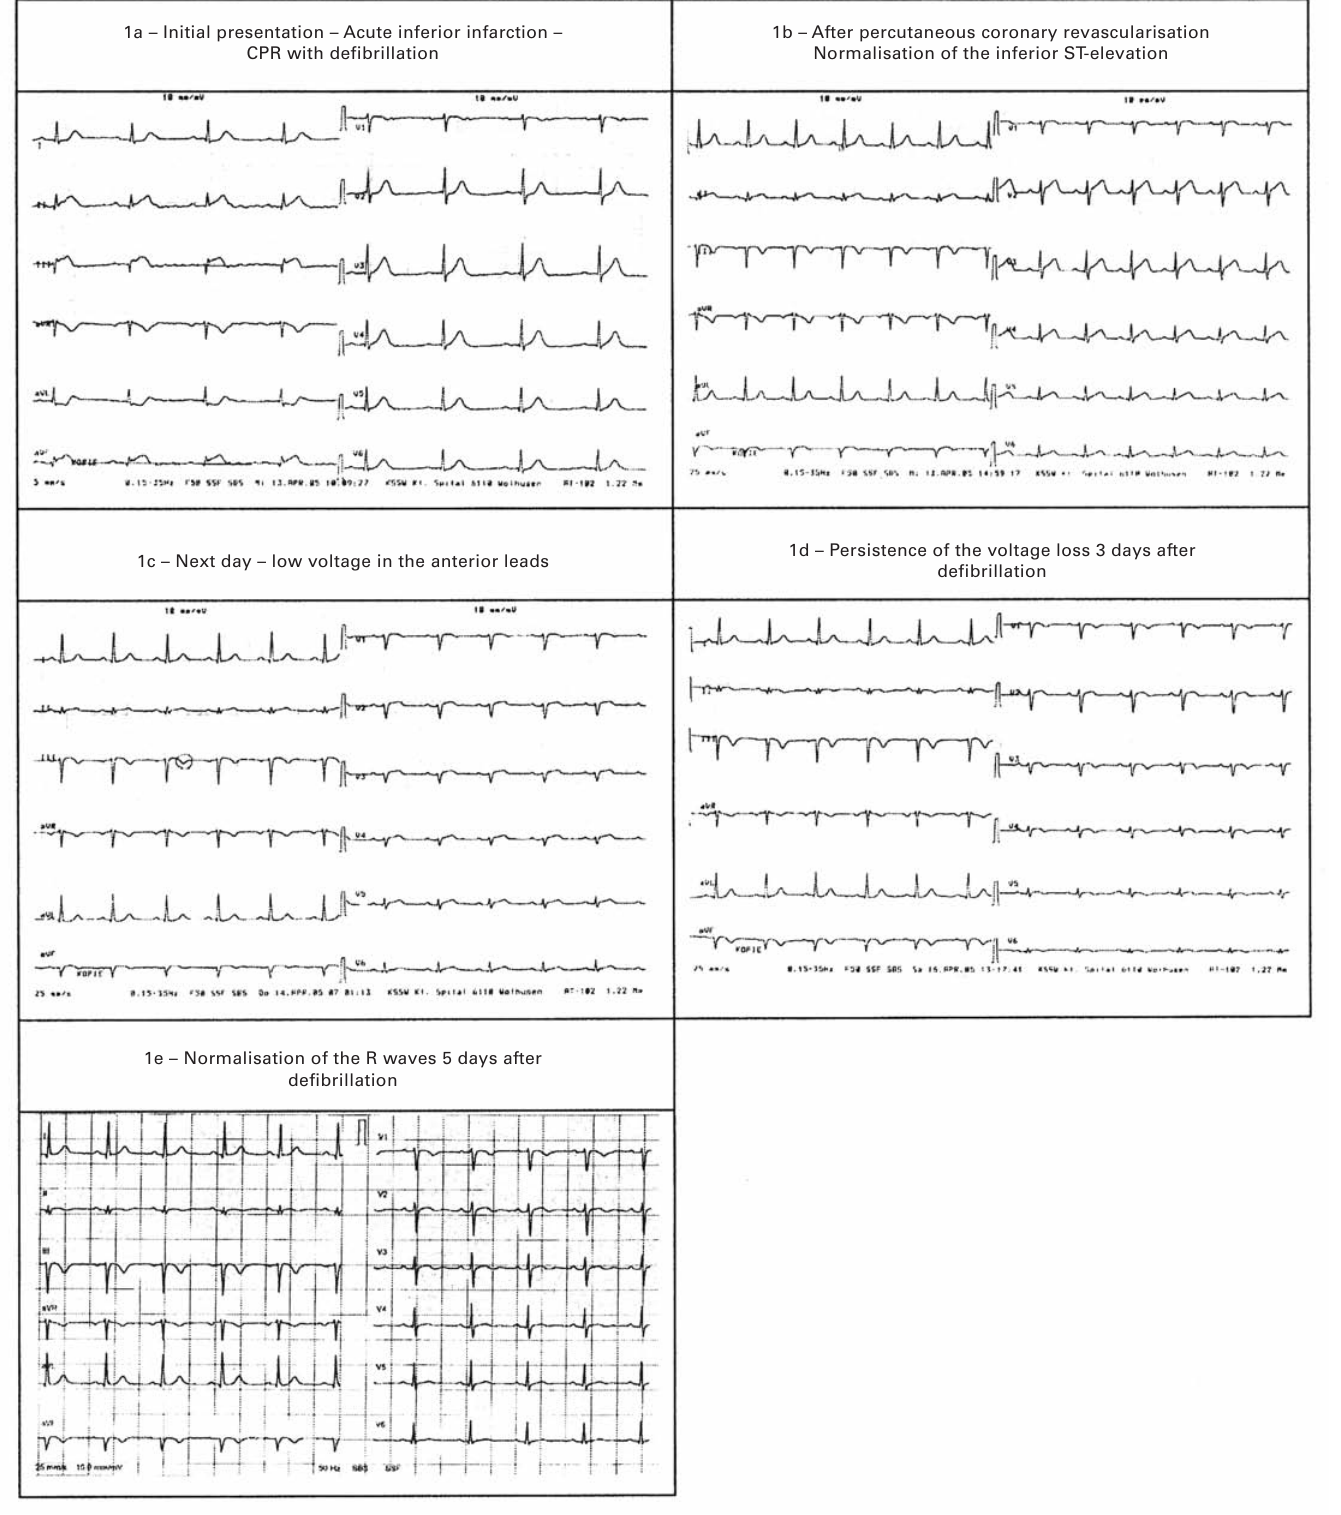
(a–e) ECG changes in a patient after